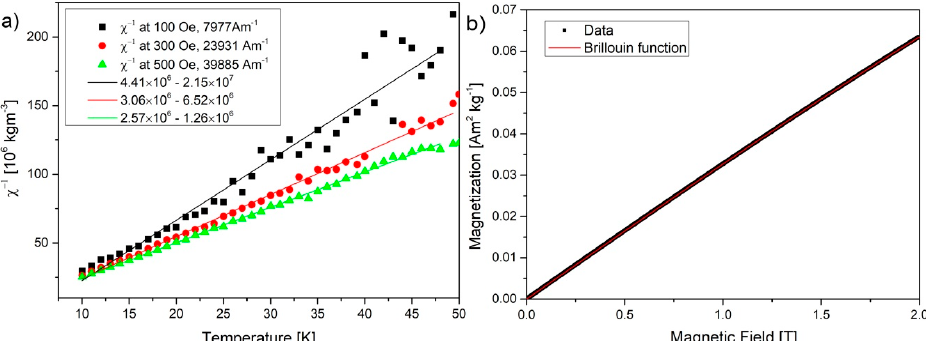
Figure 4. ( a ) Reversed magnetic susceptibility χ − 1 as a function of temperature in the range 10–50 K measured at three different magnetic fields (indicated by different symbols); ( b ) magnetization as a function of magnetic field (0–2 T) fitted with the Brillouin function R 2 = 0.9999. All measurements were performed on obtained dried GOQDs.